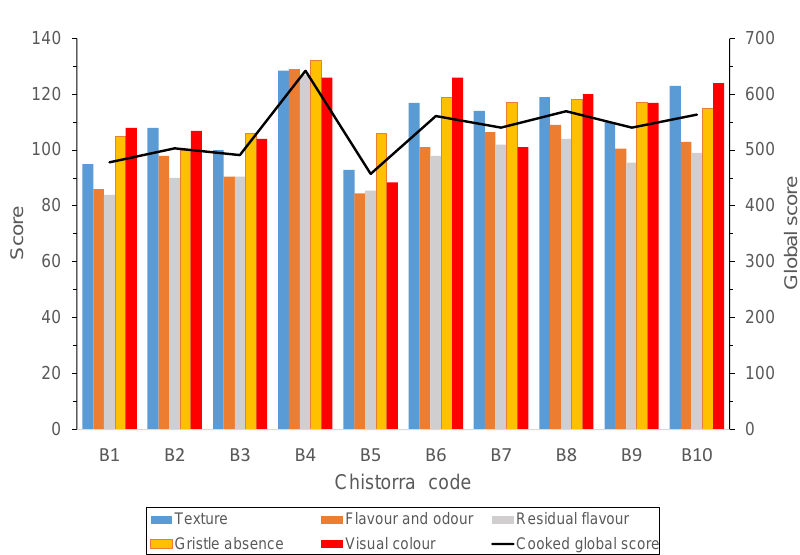
Figure 2. Results of the sensory evaluation for the chistorras in step 3 ( n = 10).